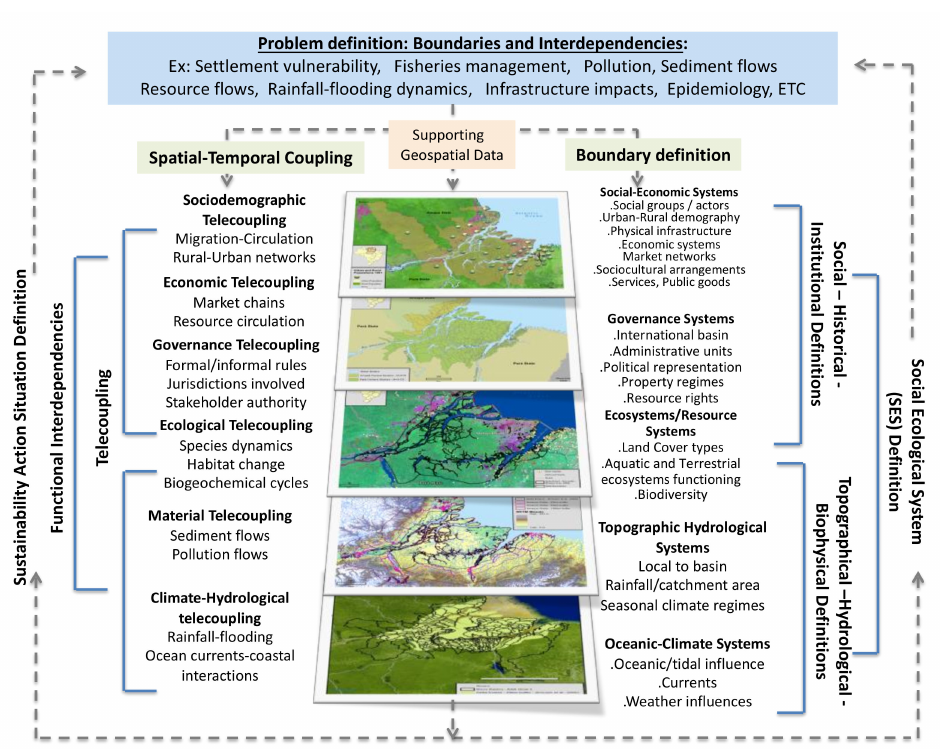
Figure 5. The Amazon delta as a coupled social-ecological system (SES): Boundaries and interconnec- tions/telecoupling dimensions. From [2] with permission from Springer.